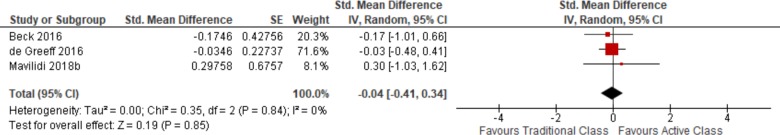
Executive function.